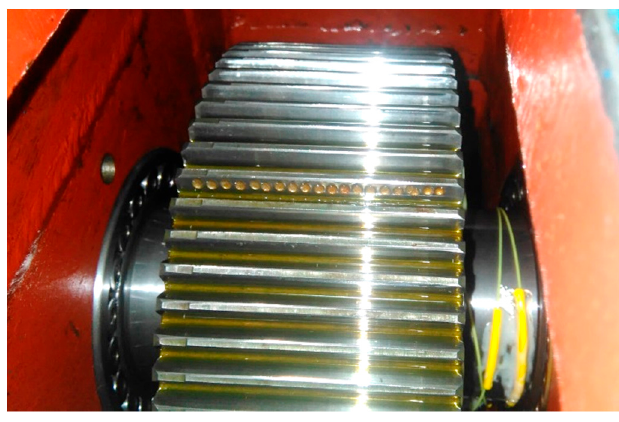
Figure 7. Simulated gear pitting fault.